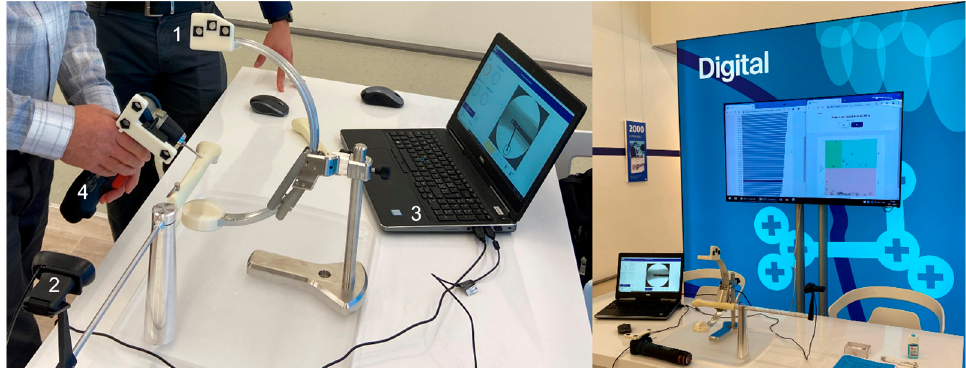
Figure 1. Digitally Enhanced Hands-On Surgical Training (DEHST) module for distal nail interlocking. 1: Model of a C-arm with reference markers for optical tracking; 2: Conventional optical camera; 3: Computer with imaging engine for simulation of X-ray images; 4: Angulated power drill with reference markers. Right: Training station at AO Davos Courses 2021 with score board presenting participants’ performance in relation to the tested peer group.